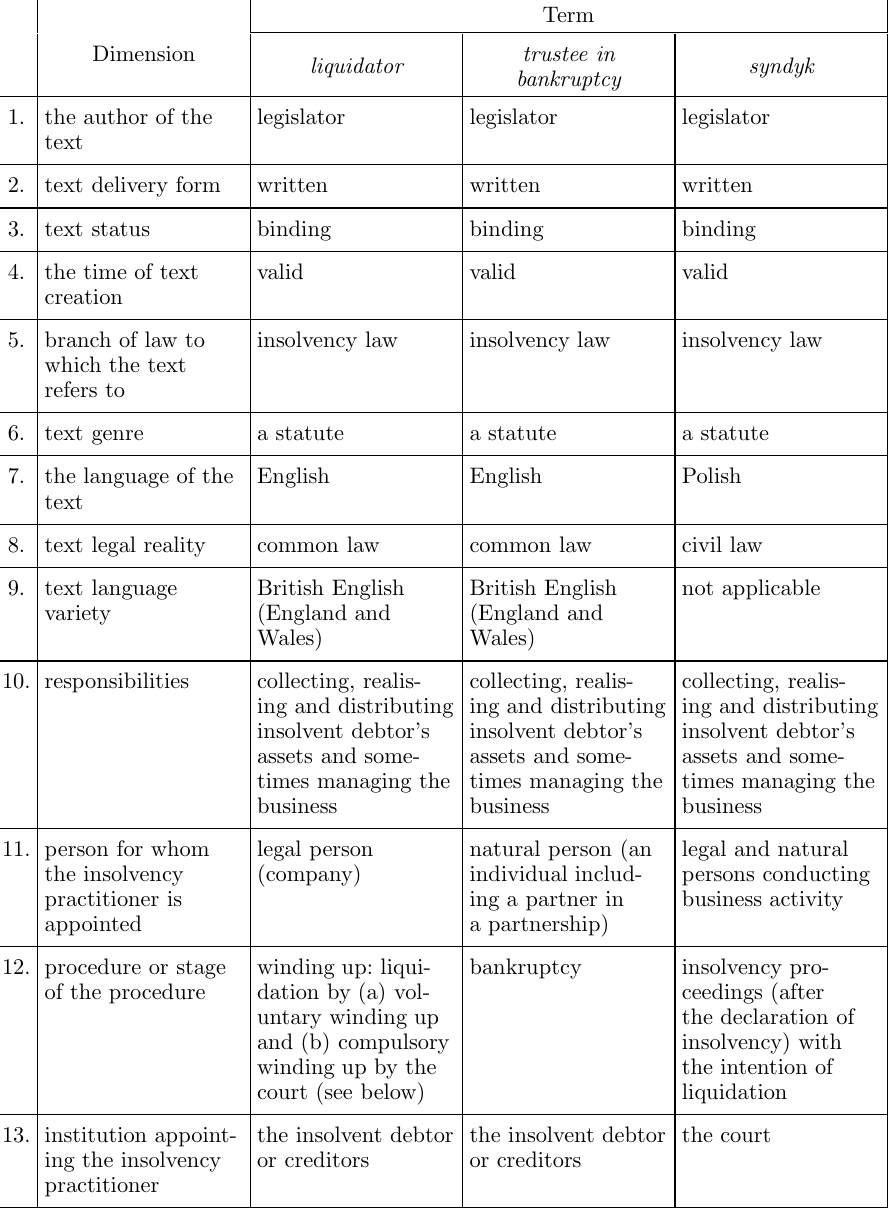
Parametrisation of the terms: liquidator , trustee in bankruptcy and